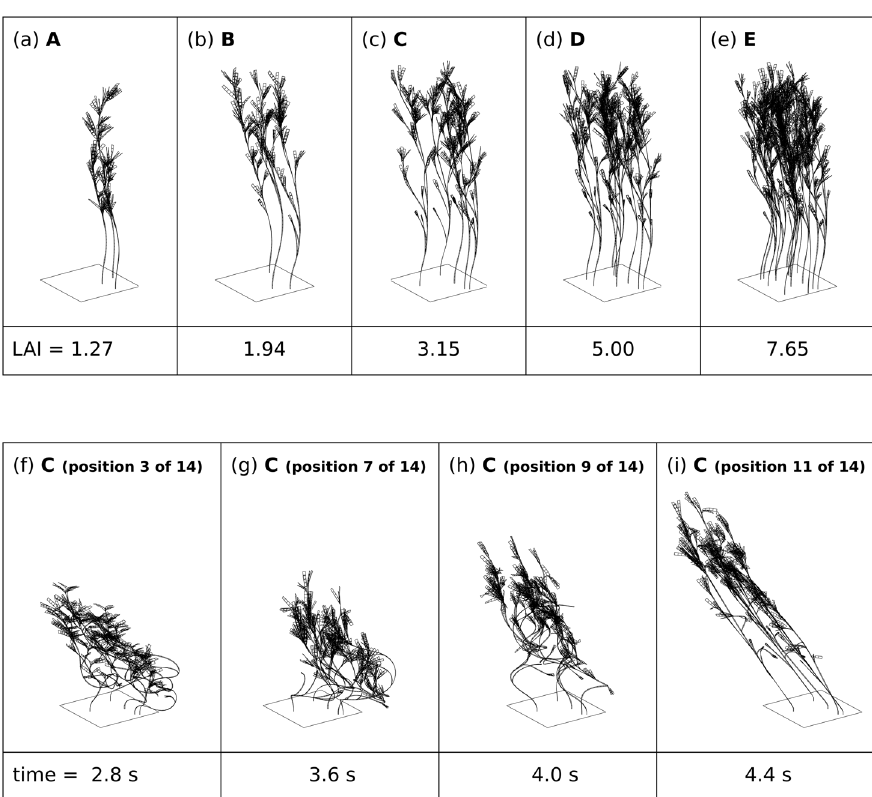
Figure 2. Example canopy structures and positions used in the model treatments. (a)–(e) low wave action canopy position for the five LAI treatments A to E. (f)–(i) subset of time sequence positions under high wave action for canopy C, all 14 positions were used in the optical model. In all cases the canopy structure is notionally repeated in all horizontal directions such that the square substrate section tessellates.